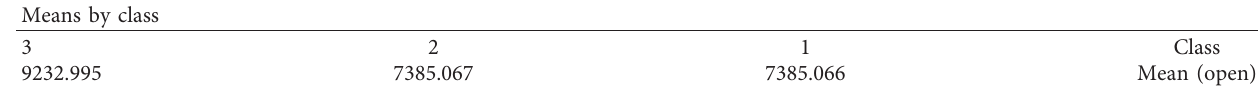
Table 3: The mean by the three components.